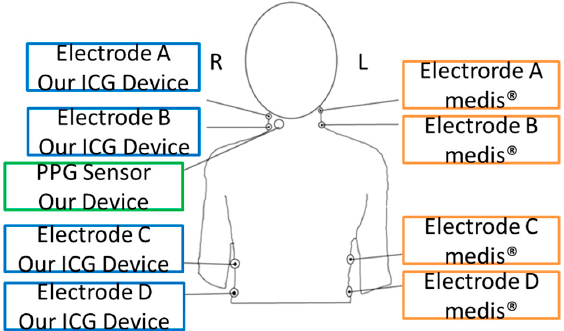
Figure 7. Four electrodes of medis ® CS2000 are placed on the left side, and other four electrodes of our ICG device are placed on the right side, and the PPG sensor is placed upon the right carotid artery.